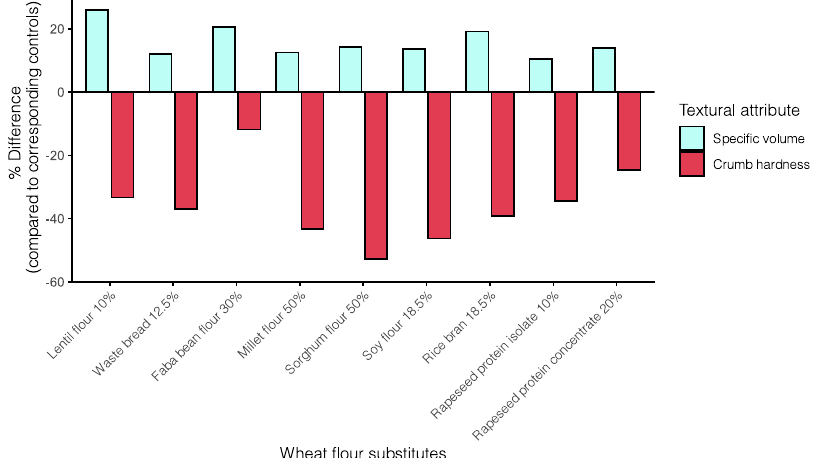
Fig. 5 Improvement (expressed as % difference) in speci fi c volume and texture of various types of composite bread by fermentation with dextran-producing Weissella confusa